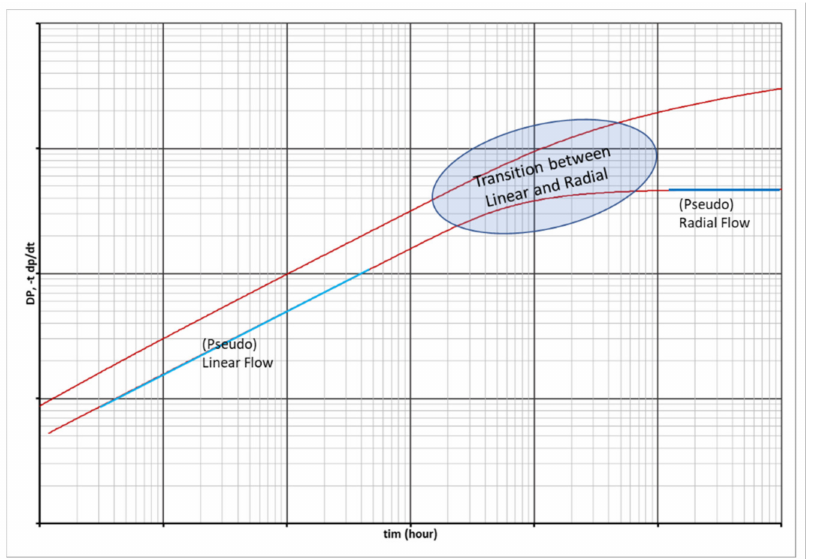
Figure 17. The New Developed Analytical Equation by Author showing All 3 Flow